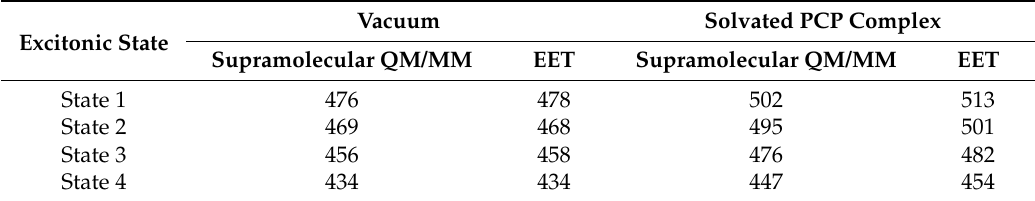
Comparison of Per absorption wavelengths simulated with a supramolecular or fragment-based excitonic quantum mechanical (QM) approach in different environments. QM/MM: quantum mechanical/molecular mechanical; EET: electronic energy